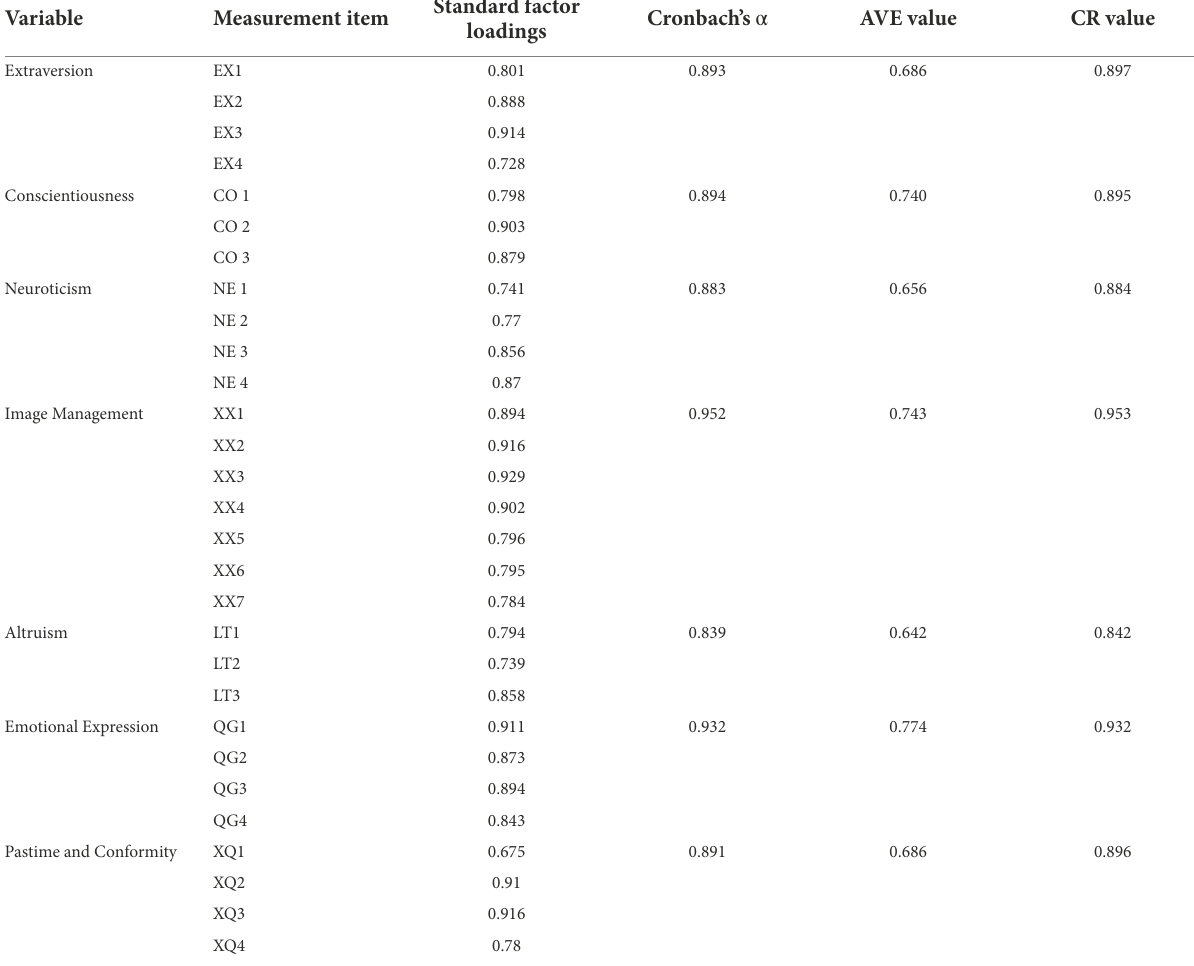
TABLE 4 Reliability analysis indicators and